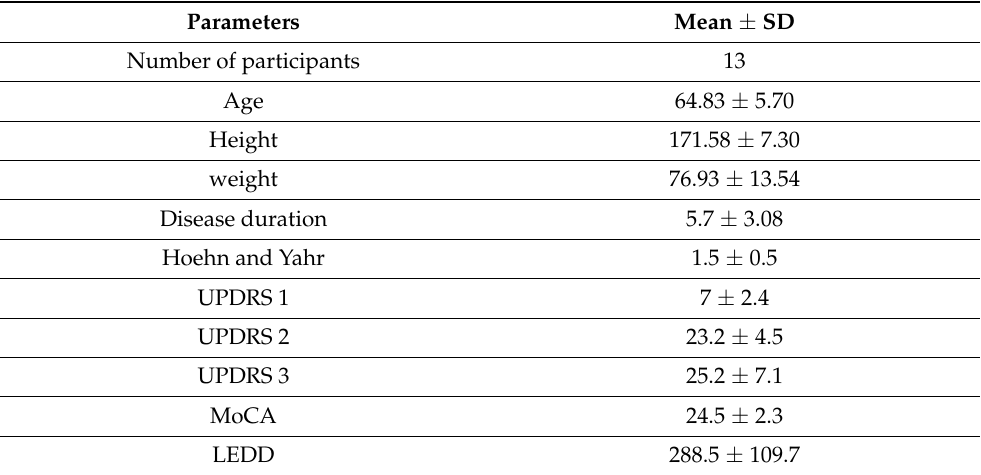
Table 2. Clinical and anthropometric characteristics of patients with PD (mean,